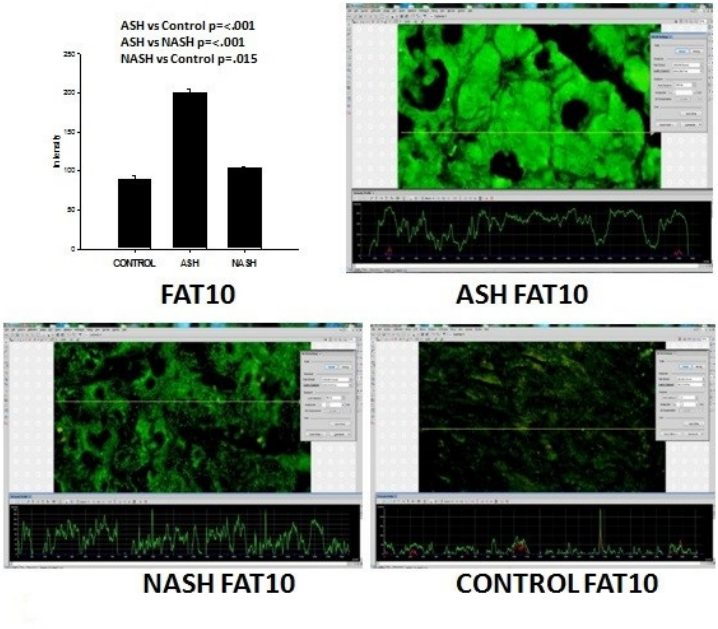
Figure 5. Graphs of FAT 10 fluorescent intensity staining measurements in Control, ASH and NASH. The intensity in ASH vs. control is p ≤ 001; ASH vs. NASH p ≤ 001; NASH vs. control is p = 015. Immunohistochemistry slides FAT10 in human biopsies ASH, NASH and Control. FAT10 is sequestered within MDBs in AH, suggesting that the excess expression of FAT10 in AH is due to the stabilizing of the protein due to a loss of protein quality